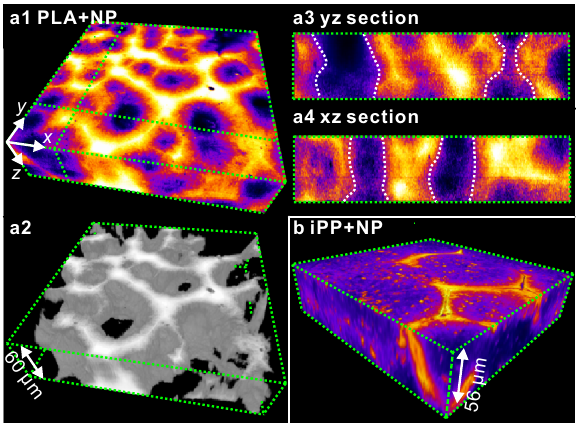
Fig. 3 3D morphology of fully crystallized polymers with NR-labeled silica nanoparticles. a PLA containing 1.3 wt % of 200nm NR-labeled nanoparticles fully crystallized at 120°C. a1 False-color solid (color scale as in Fig. 1); ( a2 ) “ porous ” rendering of the same region; ( a3 , a4 ) vertical yz and xz sections along the green dotted lines in a1 . Note some preference of spherulites to form vertical columns. b iPP containing 1.3 wt % of NR-labeled 200nm SiO 2 NPs fully crystallized at 135°C. Both in PLA and in iPP the NPs tend to concentrate at spherulite